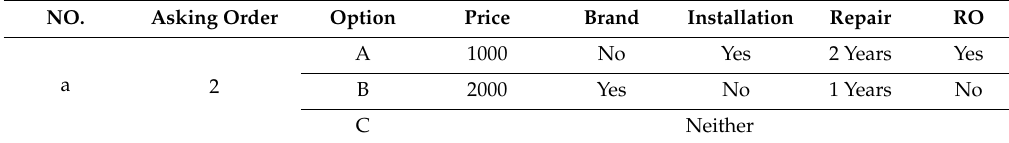
Table 2. Example of a choice